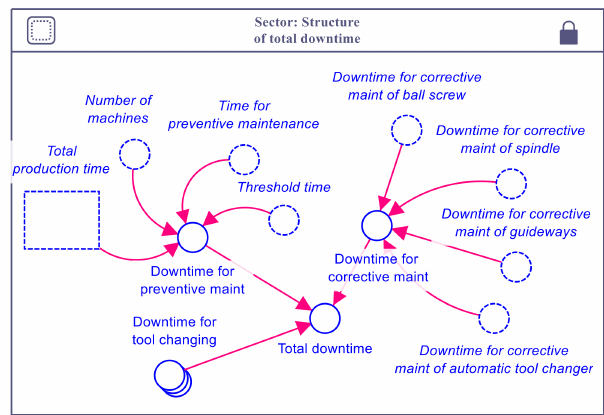
Figure 11. Structure of downtime and uptime.